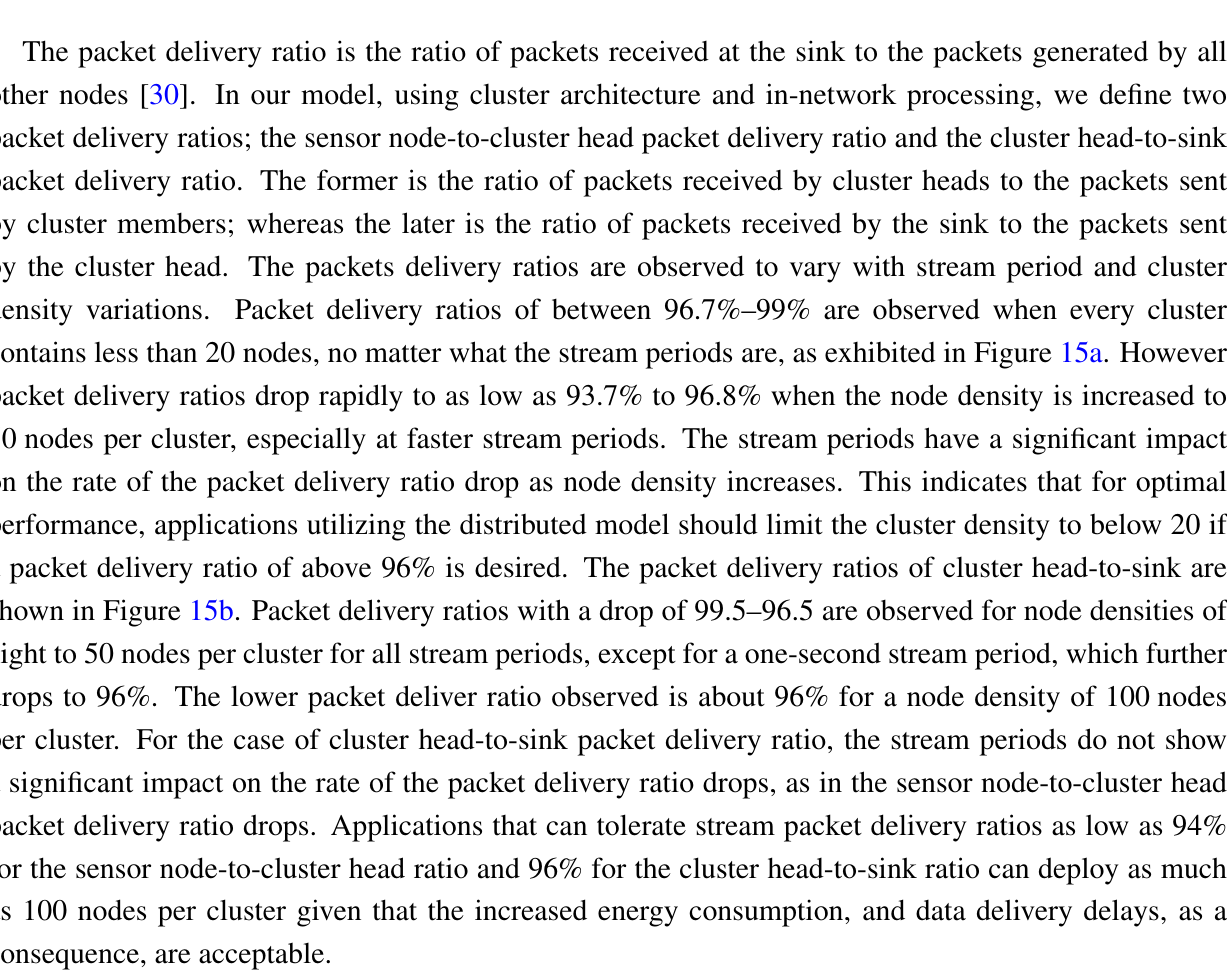
15. The packet delivery ratios of node-to-cluster head and cluster head-to-sink. ( a ) Packet delivery ratio of sensor node-to-cluster head; ( b ) packet delivery ratio of cluster head-to-sink